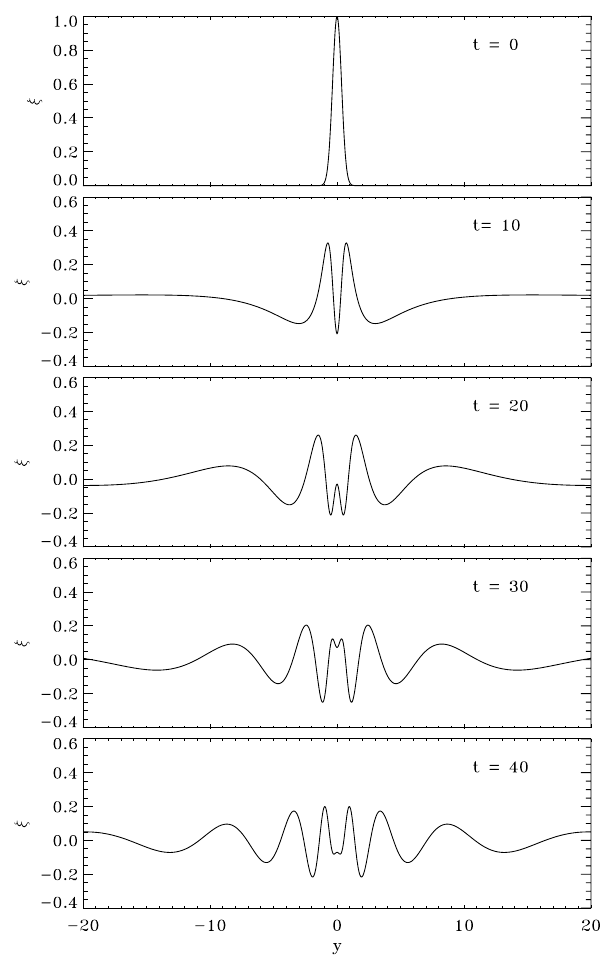
Fig. 7. Flapping waves propagating from the source localized to the center of the current sheet.